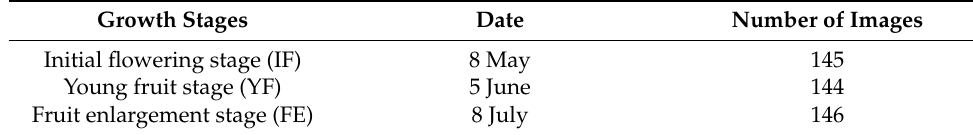
Table 1. Image information obtained by UAV.